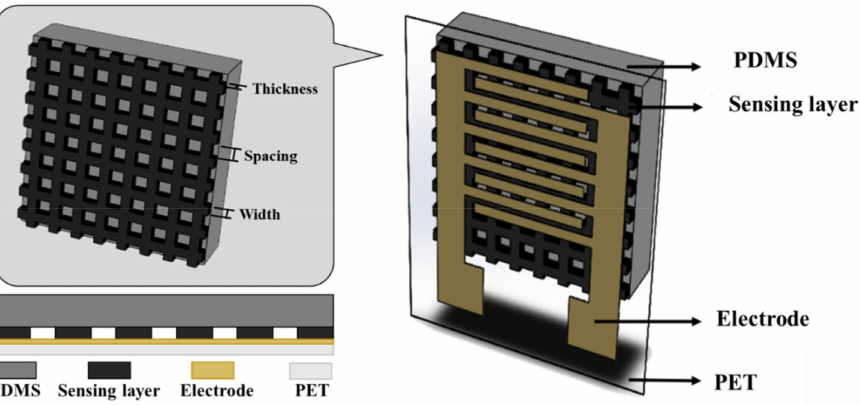
Figure 2. Schematic of the flexible piezoresistive tactile sensor with grid–type microstructures.